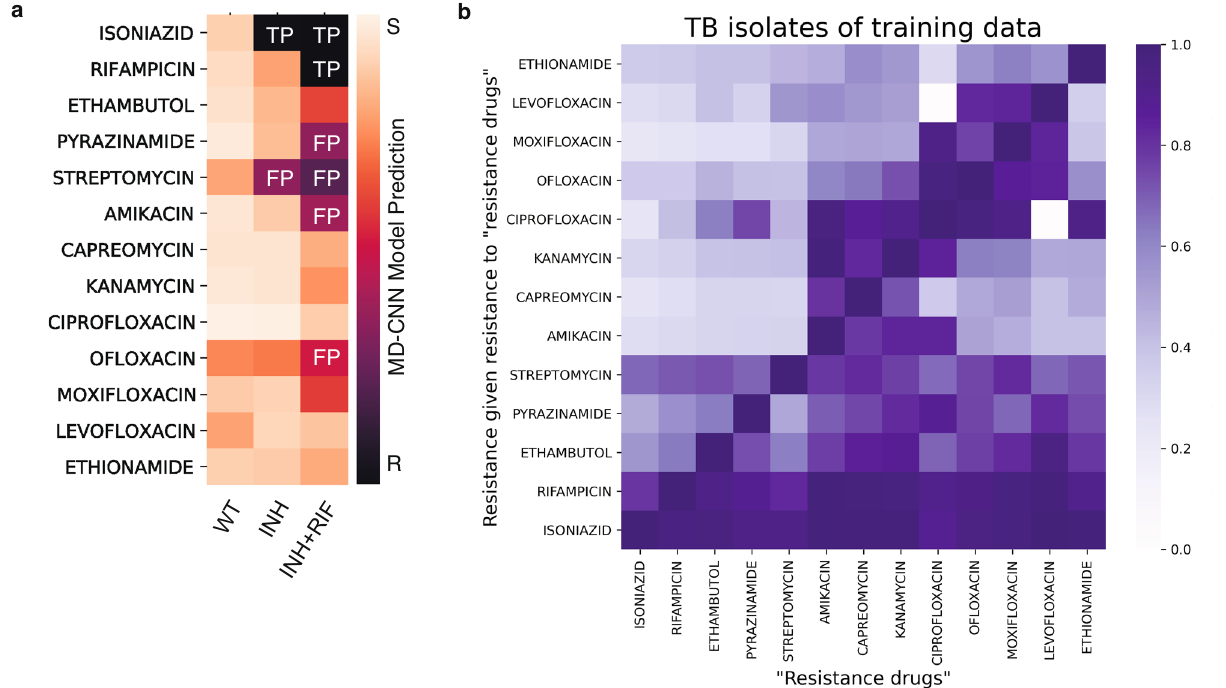
Fig. 4 MD-CNN learns dependency structure of antibiotic resistance. a Introduction of single resistance-conferring mutations into pan-susceptible wild- type background (H37Rv, “ WT ” ) is suf fi cient to cause the MD-CNN model to predict false positive resistances. A single isoniazid-resistance conferring mutation (2155168G, “ INH ” ) or one isoniazid- and one rifampicin-resistance conferring mutations (2155168G and 761155T, “ INH + RIF ” ) are introduced in silico into the wild-type background sequence and resistances are predicted using the MD-CNN model. b Dependency heatmaps of drug resistance for training isolates. The horizontal axis represents the drugs to which isolates exhibit resistance. Based on this condition of resistance, the proportions of resistance to other drugs (vertical axis) are